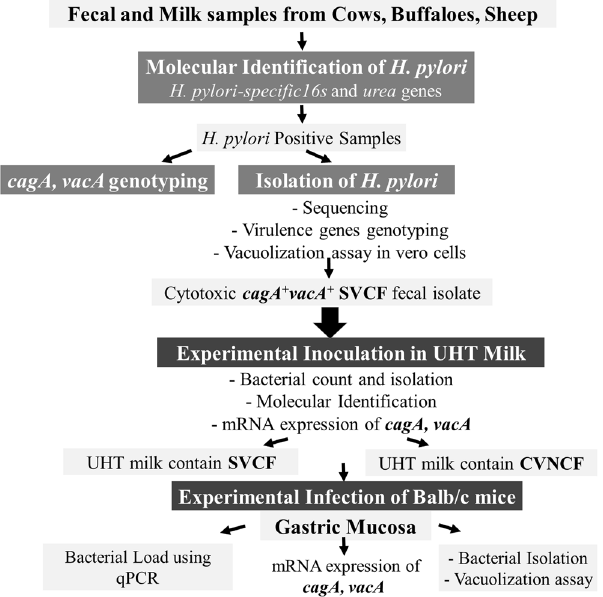
Figure 1. Schematic flow chart of the study design. Fecal and milk samples were collected from apparently healthy livestock and were subjected to PCR targeting H . pylori -specific 16s and ureA genes. The PCR positive samples were further subjected to genotyping of the virulence genes cagA and vacA and to bacteriological culture. The bacterial isolates were examined for cagA and vacA genotypes and for cytotoxicity using vacuolization assay. The fecal isolate with predominant cytotoxic genotype cagA + vacA s1a m1 i1 was inoculated in UHT milk and its survivability under different temperatures was determined. The UHT milk that contains the survived H . pylori strains were fed to healthy experimental mice groups for 40 days. The gastric mucosa was collected following scarification of the mice groups and was examined by real-time/quantitative polymerase chain reaction (qPCR) to estimate the load of infection. The gastric mucosa was further subjected to bacteriological culture and the mRNA expression of cagA and vacA was detected by reverse transcription PCR